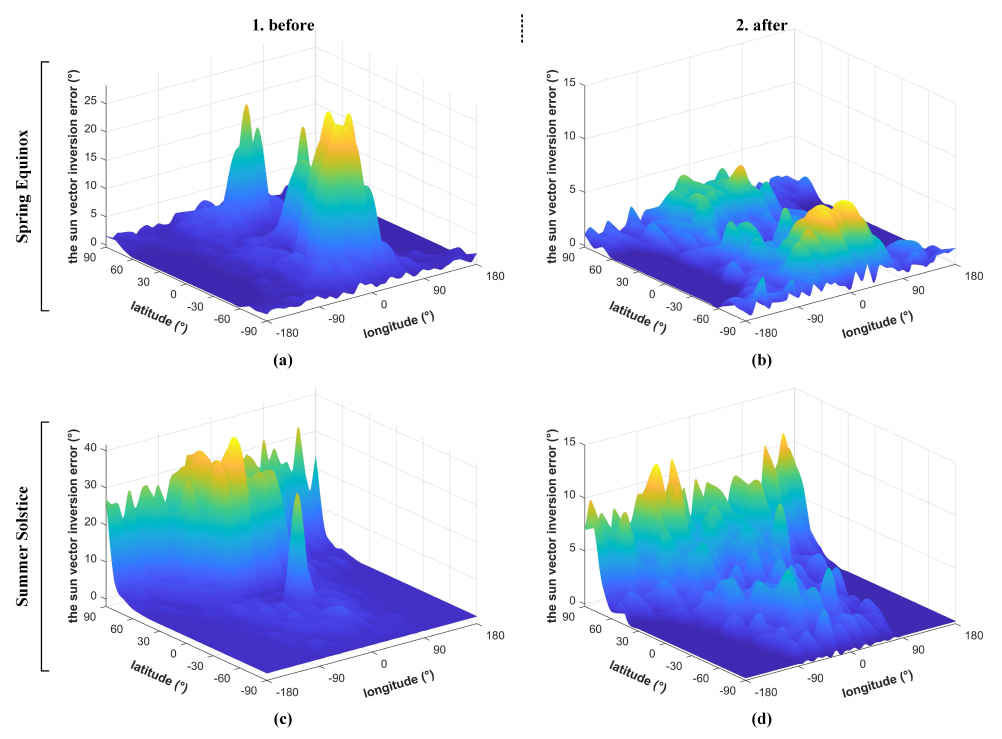
Figure 13. The sun vector inversion accuracy before and after invalid measurements culling. At the Spring Equinox ( a , b ) the overall accuracy improves from 4.84 ◦ to 1.84 ◦ . At the Summer Solstice ( c , d ), the overall accuracy improves from 7.41 ◦ to 2.16 ◦ .